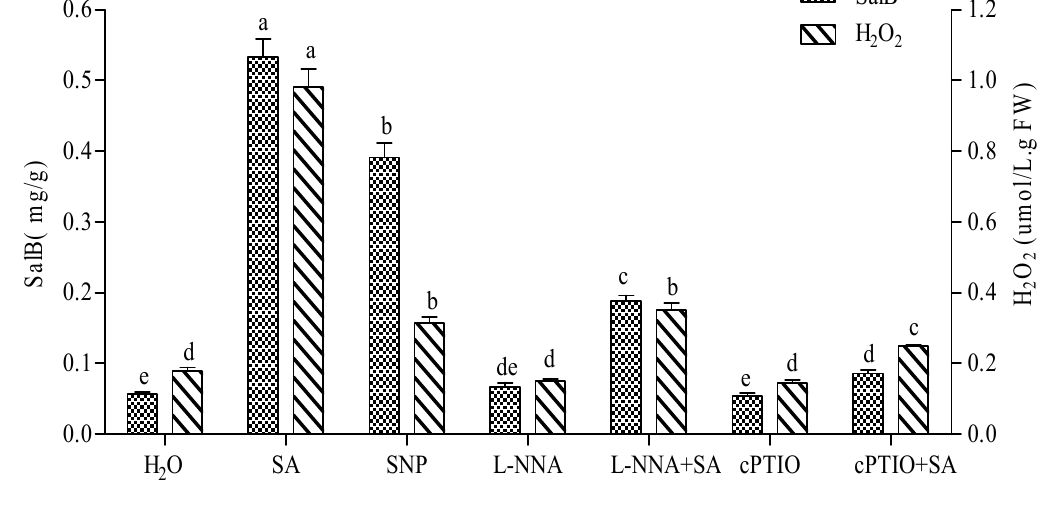
Figure 3. Effects of SA, SNP, L-NNA, cPTIO and complex treatments on the production O in Salvia miltiorrhiza cell cultures. The concentrations for SA, SNP, of Sal B and H 2 2 L-NNA and cPTIO were the same as Figure 2. The detection time for determining both O and Sal B was the same as Figure 2. Different lowercase letters contents of H 2 2 represented significance at